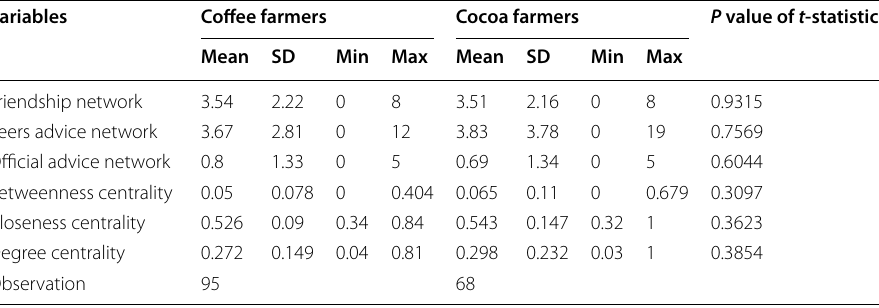
Table 6 Summary statistics of the network variables